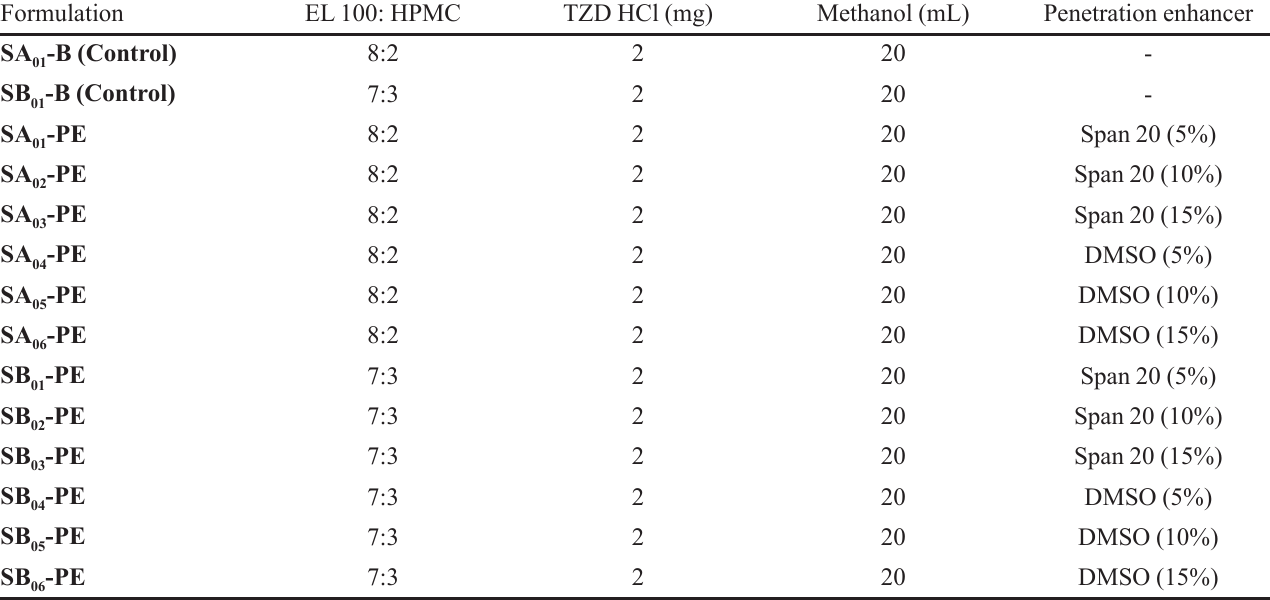
TABLE II - Composition of different transdermal formulations of TZD HCl containing permeation enhancers